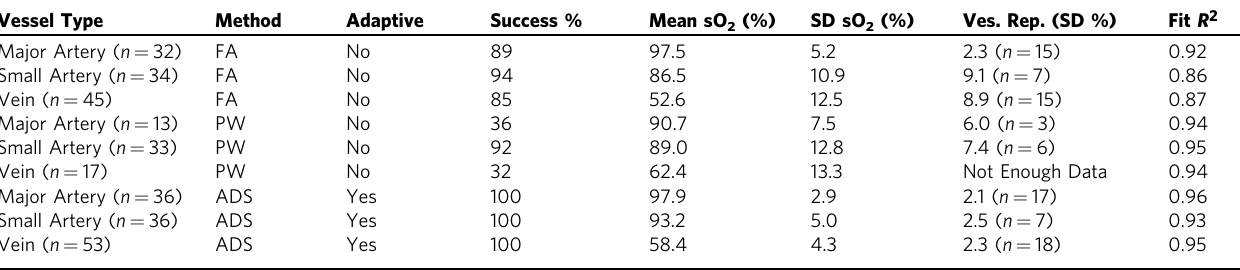
Table 1 Comparison of different vis-OCT oximetry methods. Vessel